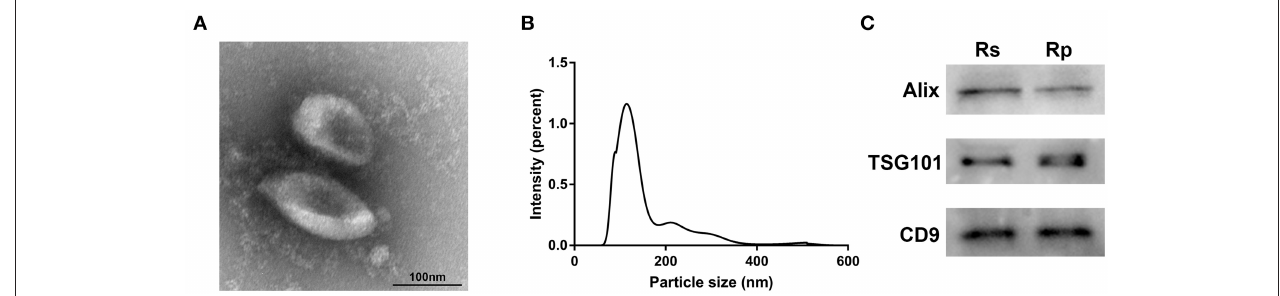
FIGURE 1 | Characterization of exosomes derived from the plasma of chemoresistant and chemosensitive CRC patients. (A) The morphology and size of exosomes by TEM. (B) The size distribution of exosomes, analyzed by NTA. (C) Western blots of the exosomal markers: CD9, Alix, and TSG101. Rs, Resistance; Rp,